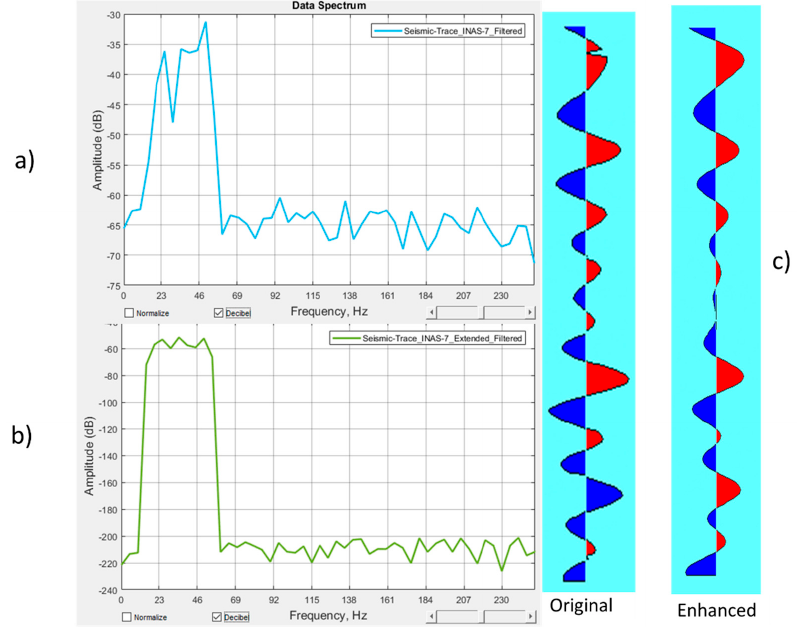
Figure 15. Comparing the original ( a ) and the spectrally inverted (and harmonically extrapolated) filtered traces ( b ); ( c ) illustrates a comparison between the original trace with the enhanced trace. In comparison, the enhanced trace has a better correlation with the acoustic imped- contrast of the geologic reflectors, the reflection coefficients (RC) responses at the interface